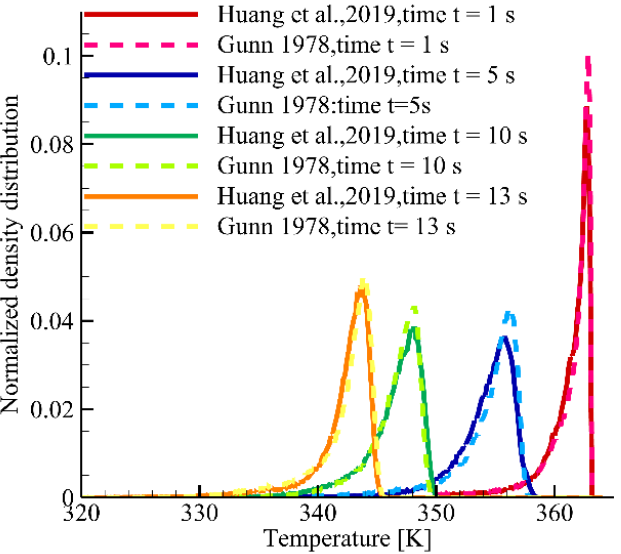
Figure 4. Comparison of particles’ mean temperature from the experiments with the prediction from the simulations. Huang et al., 2019 [9], Gunn., 1978 [14], Patil et al., 2015 [30].